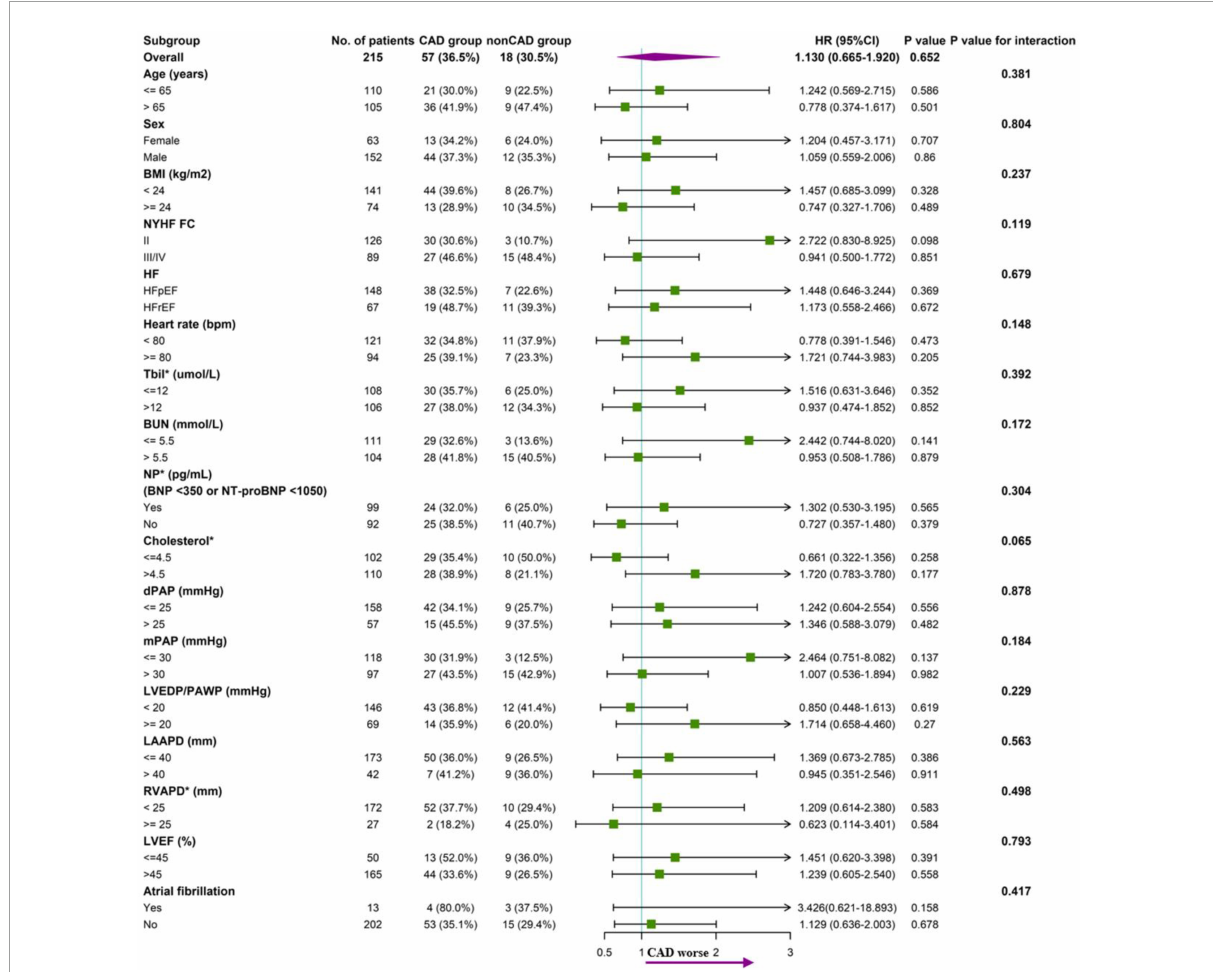
FIGURE4 Forest plot of subgroup analysis of association between CAD and endpoint (all-cause mortality), with p value for interaction.